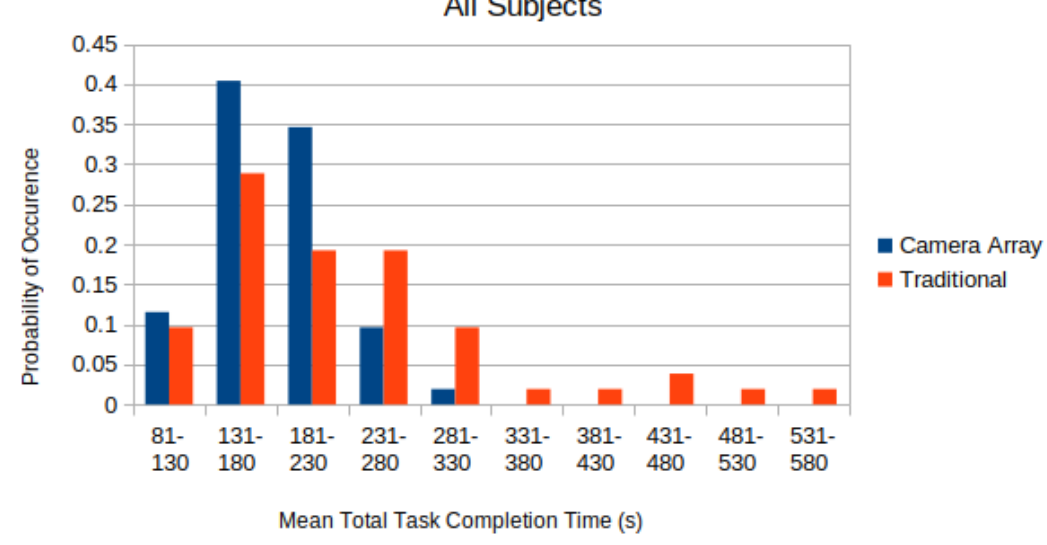
Figure 7. Distribution of Completion Time (with 28 s penalty for each failed